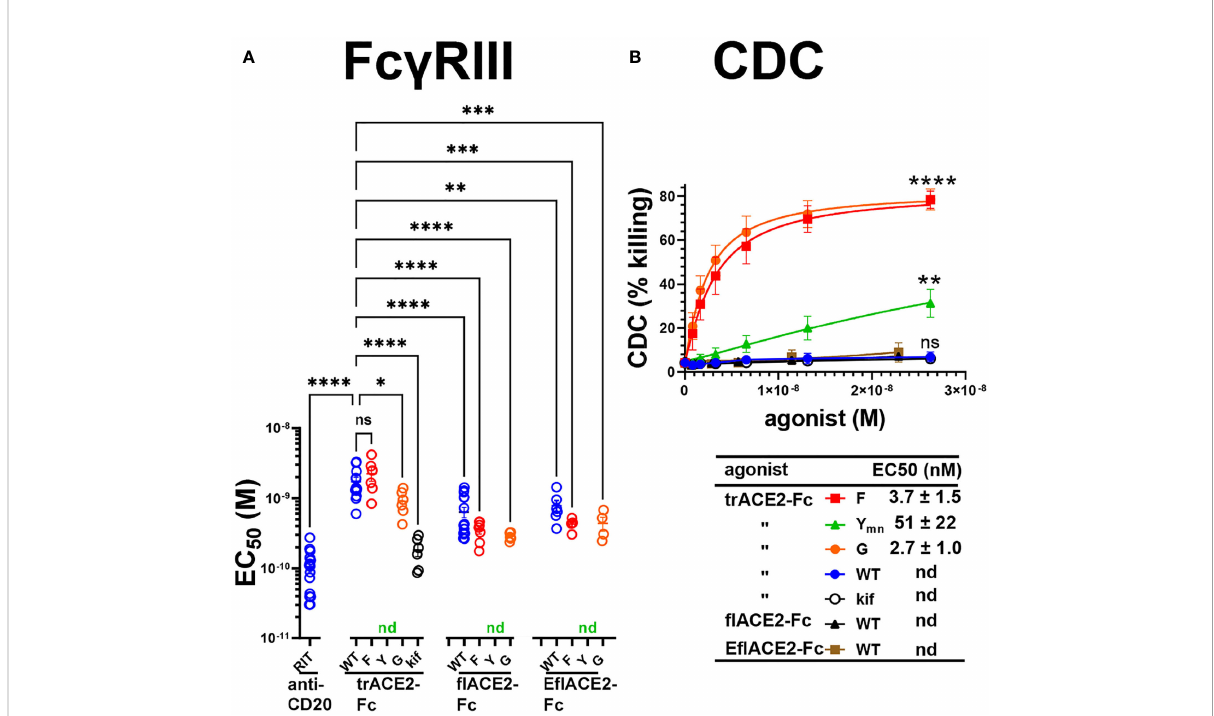
FIGURE 5 Fc g R and complement dependent effector functions of the ACE2-Fc decoy proteins. (A) Activation of Fc g RIIIa by ACE2-Fc proteins. ACE2-Fc proteins activated Fc g RIIIa, except for the Fc H429Y mutants which failed to stimulate in any ACE2 format either as oligomeric or monomeric forms. Ramos-S target cells were opsonized with trACE2-Fc, fl ACE2-Fc and E fl ACE2-Fc, WT and Fc variants, including H429F, F; H429Y, Y; E430G, G or trACE2-Fc -kif , produced from trACE2-Fc WT in 293Expi cells in the presence of the mannosidase inhibitor kifunensine. In some experiments Ramos-S target cells were separately opsonized with Rituximab, RIT. These opsonized targets were incubated with Fc g RIIIa/NF- k B-RE nanoluciferase reporter cells and Fc g RIIIa activation measured by the induction of nanoluciferase (RLU). Activation data ( Supplementary Figures S1B, C ) were fi tted to agonist response curves to estimate EC 50 (nM); nd, not determined as there was insuf fi cient activity for the data to be fi tted. EC 50 values from the curve fi ts are shown. Mean ± SEM, n is indicated by individual symbols for each independent experiment, one-way ANOVA with Dunnett ’ s multiple comparisons test, comparing to trACE2-Fc WT. p > 0.05 (ns), ≤ 0.05 (*), ≤ 0.01 (**), ≤ 0.001 (***), ≤ 0.0001 (****). (B) H429F, and E430G Fc mutant ACE2-Fc proteins are potent mediators of complement lysis of SARS-CoV-2 S expressing cells. Flow cytometric analysis of complement-dependent cytotoxicity (CDC) of opsonized Ramos-S cells was determined in the presence of a 1/3 dilution of a pool of normal human serum (from >5 individuals) as a source of complement. Plots are mean ± SEM, n = 3 independent experiments. Two-way ANOVA with Dunnett ’ s multiple comparisons test comparing to trACE2-Fc-WT for main column effect, p > 0.05 (ns), ≤ 0.01 (**), ≤ 0.0001 (****). EC 50 (nM) values are mean ± SEM each from 3 curve fi